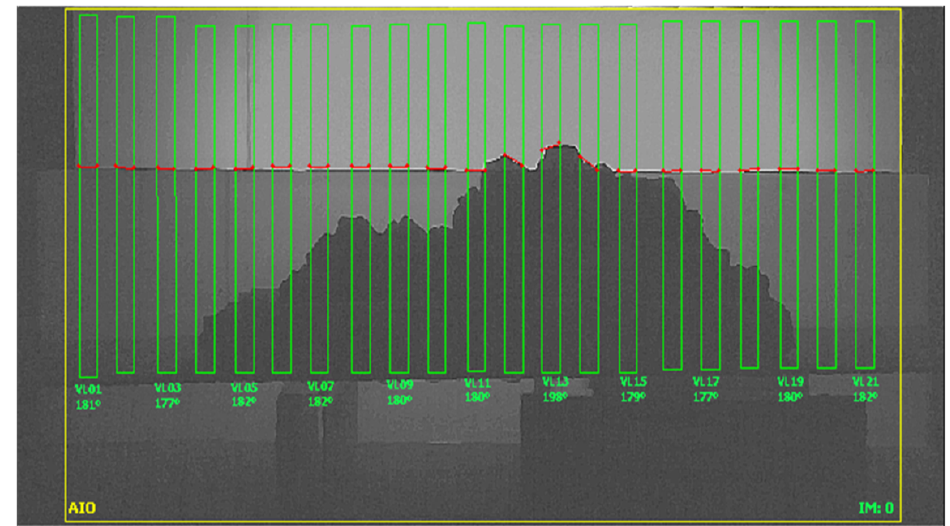
Figure 4. Definition of the 21 virtual level (VL) probes to perform the measurements of the iden- tified edges. The degree values indicate the angle of the identified edges (in red) with respect to the